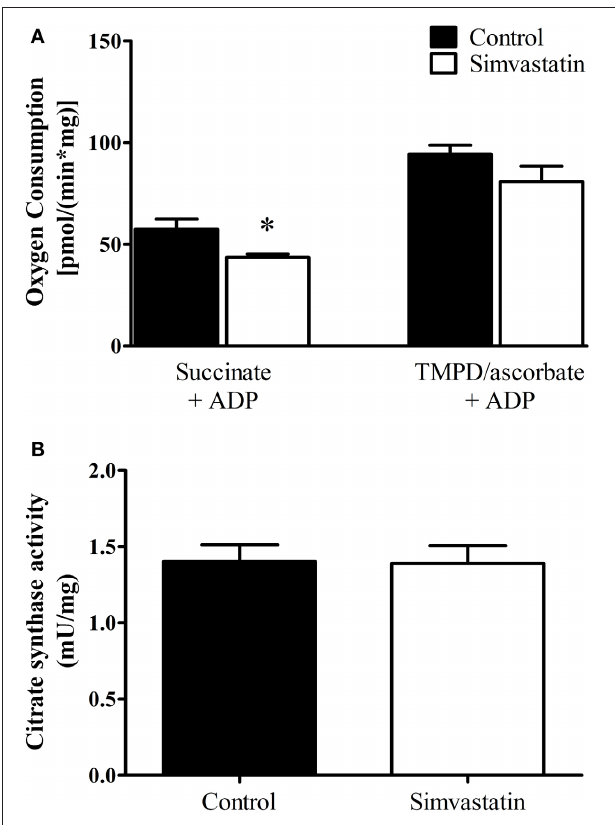
FIGURE 2 | Inhibitionby 1 µ M simvastatin of ADP-stimulatedoxygen consumption supported by succinate but not byTMPD/ascorbate. (A) Skeletalmuscle sampleswere incubatedin MiR05 mediumin the presenceof 1 μ M simvastatin, or DMSO for 1h. ADP (400 μ M) or 1 μ g/mL oligomycin plus0.2 μ M FCCP were respectivelyadded.Therespiration was supportedby5mMsuccinateor5 μ MTMPDplus2mMascorbateplus1 μ M antimycin A. (B) Skeletal muscle homogenateswere incubatedat 30 ◦ C in a buffer containing50mM tris-HCl (pH8.0),0.1%Triton X-100,250 μ M oxaloacetate, 50 μ M acetyl-CoA, and 100 μ M 5, 5 (cid:4) -dithiobis(2-nitrobenzoic acid) to assay citrate synthase activity. Prior preparation of homogenates, skeletal muscle sampleswere incubatedby1h in MiR05 mediumin presenceof 1 μ M simvastatin. ∗ p < 0 . 05vs. controlbystudent t -test. N = at least 5 independentexperiments.